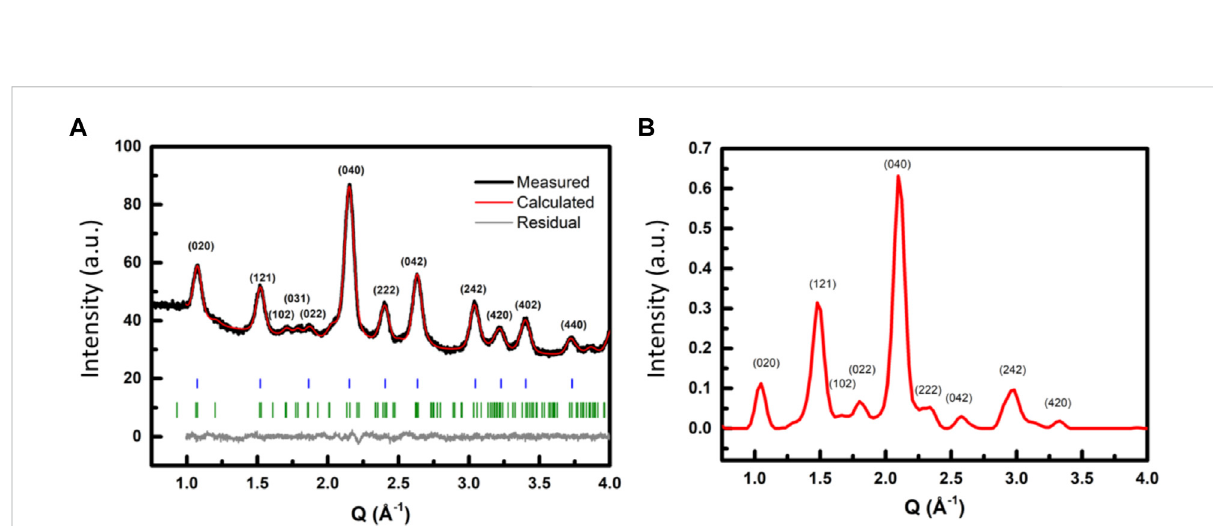
1 .Theblueandgreenbarsindicatethepeakpositionsofthecubicandorthorhombicreferencepatterns,respectively. (B) Azimuthalintegrationofthe 2D electron diffraction pattern.